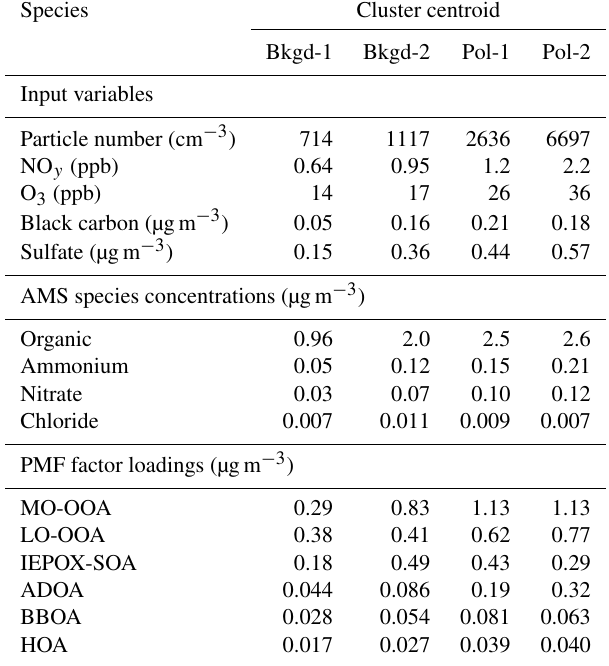
Table 2. Coordinates of cluster centroids for input variables, AMS species concentrations, and PMF factor loadings. Table entries for AMS species and PMF factors are plotted in Fig. 8. The AMS species concentrations (except for sulfate) and the PMF factor load- ings were not used as input variables in the FCM clustering analysis.